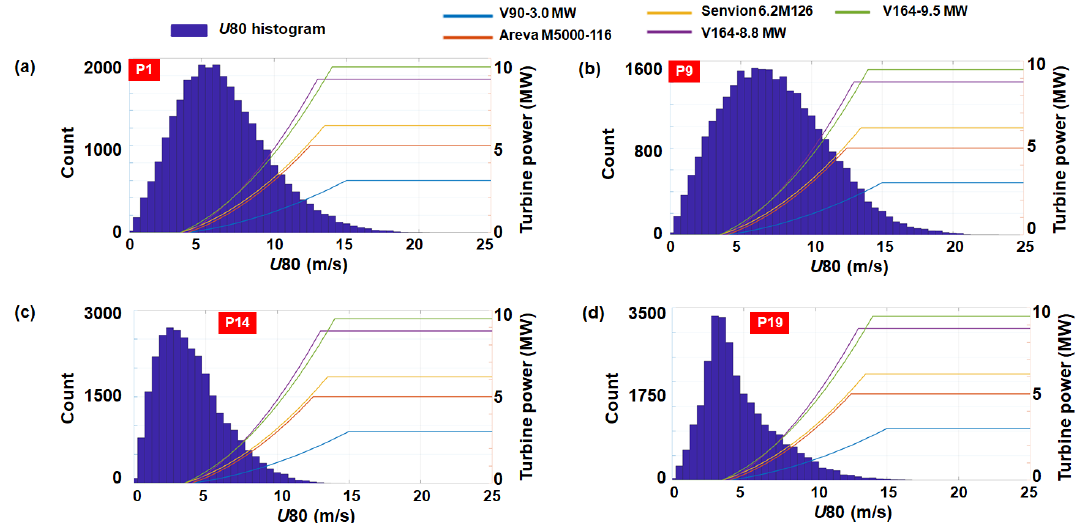
Figure 2. Representation of the wind turbine power curves and wind speed histograms ( U 80). The wind distribution is related to the ERA-Interim project (January 1998–December 2017) and includes the sites: ( a ) P1; ( b ) P9; ( c ) P14; and ( d ) P19.